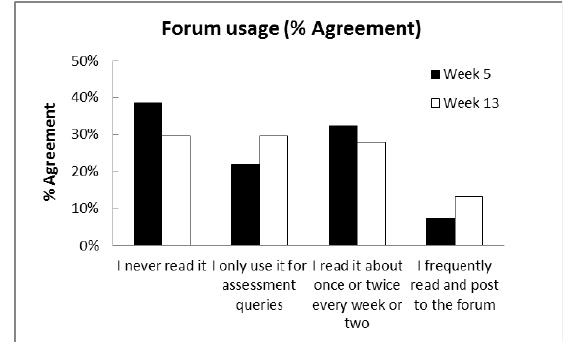
Figure 2: Forum usage (survey responses by